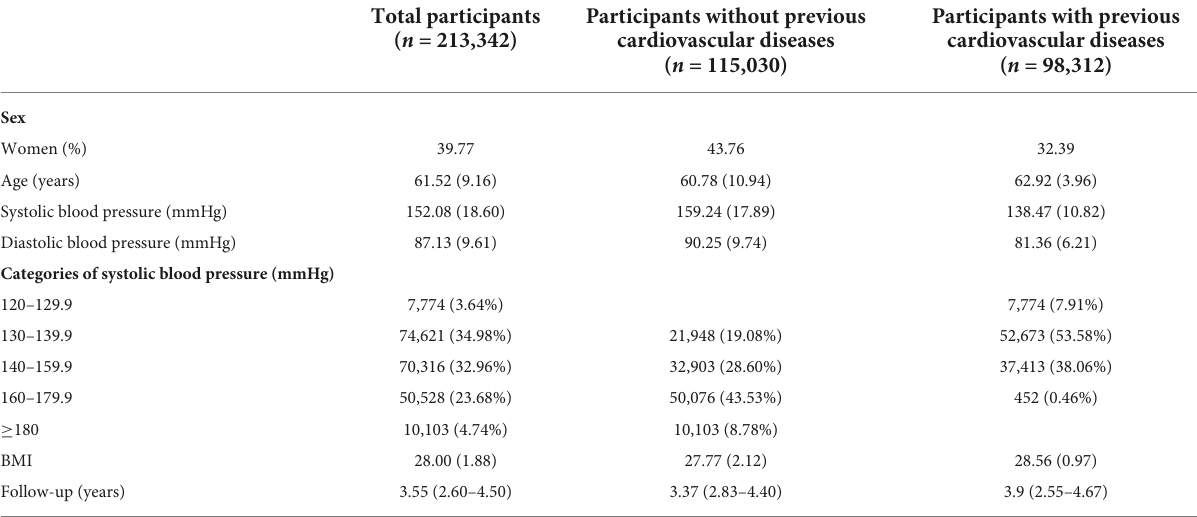
TABLE 1 Baseline characteristics of participants by cardiovascular disease status and systolic blood pressure.